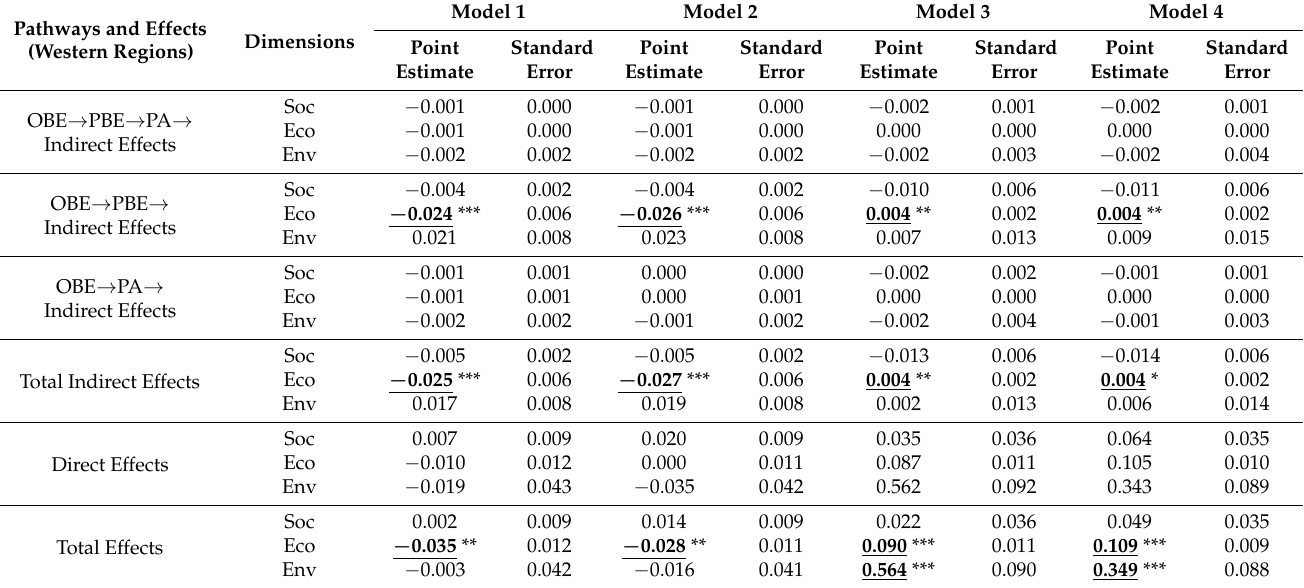
Table 8. Total, direct and indirect effects of OBE on P-RCR (western